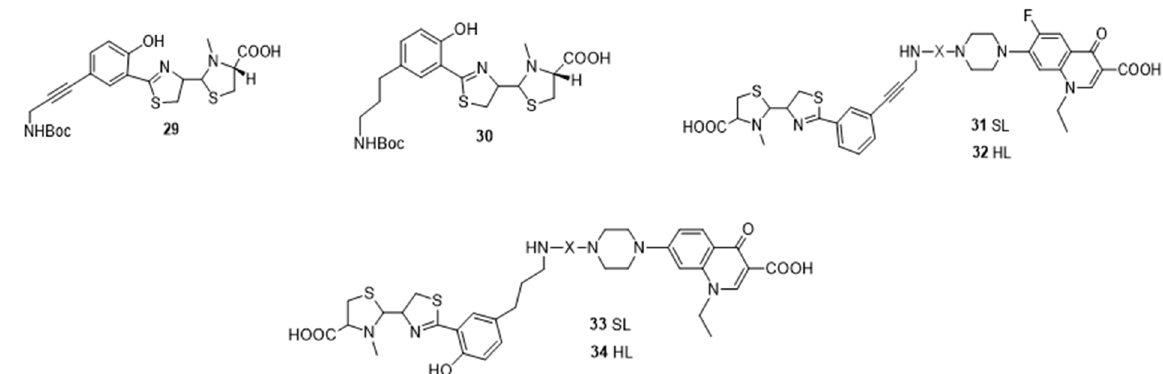
Figure 11. Pyochelin conjugates 31–34 Figure 11 . Pyochelin conjugates 31 - 34 .